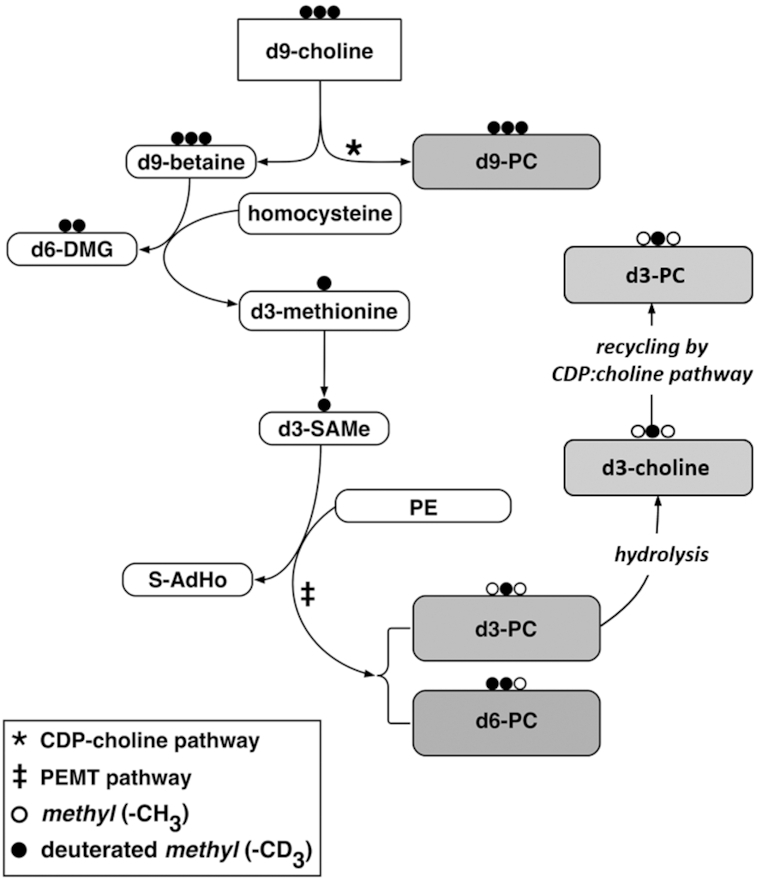
Metabolic pathway of intravenously administered choline and its methyl groups using deuterium-labeled methyl-D9-choline. Methyl groups labeled with deuterium are represented by the black dots; the unlabeled methyl groups are represented by the white dots. The methyl-D9-choline can enter the CDP-choline pathway (*) to produce D9-PC. Alternatively, it can be oxidized to D9-betaine, which then donates a single methyl group to homocysteine, producing D6-DMG and D3-methionine. D3-methionine serves as a precursor for D3-SAMe, which can be used by PEMT (‡) to sequentially methylate PE, forming D3-PC as well as smaller amounts of D6-PC. A fraction of D3-choline or D6-choline is released by hydrolysis of PEMT-derived D3-PC or D6-PC in the liver and recycled back to D3-PC or D6-PC by the CDP-choline pathway. CDP-choline, cytidine diphosphocholine; DMG, dimethylglycine; PC, phosphatidylcholine; PE, phosphatidylethanolamine; PEMT, phosphatidylethanolamine N-methyltransferase; S-AdHo, S-adenosylhomocysteine; SAMe, S-adenosylmethionine.